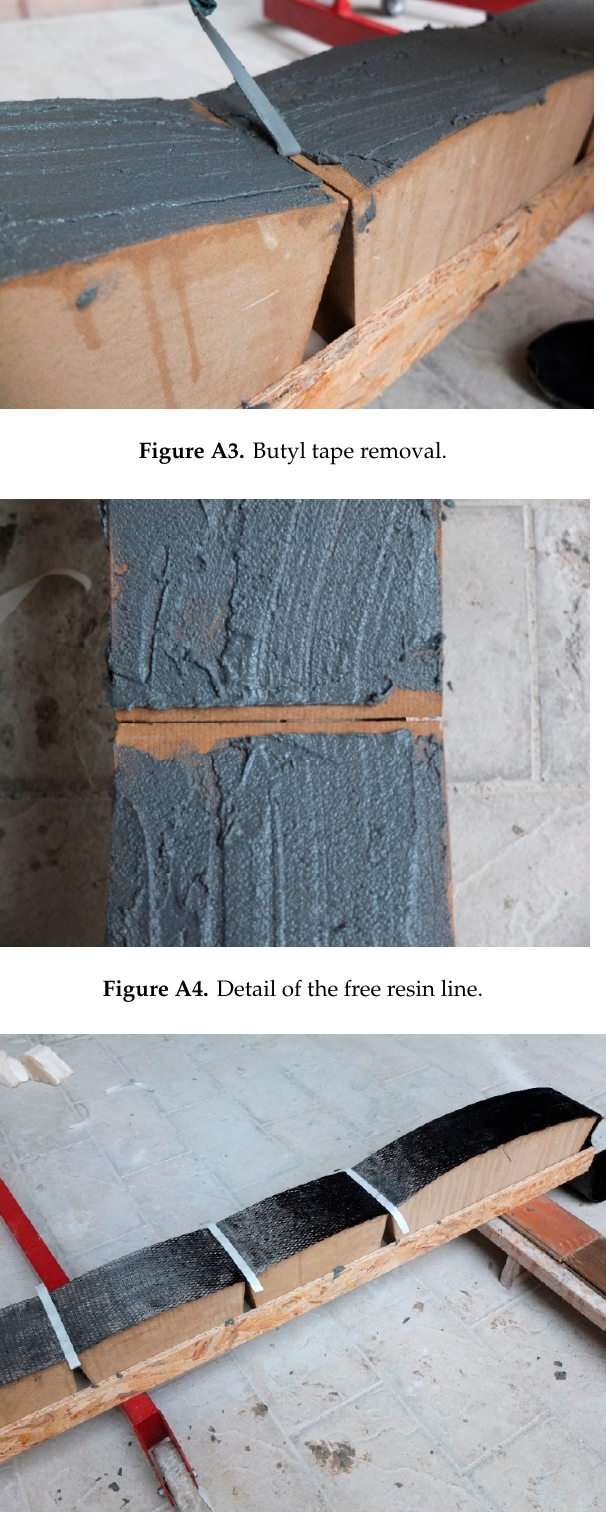
Figure A5. Butyl tape above the carbon fiber sheet.